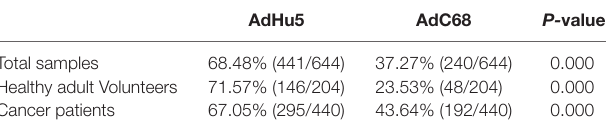
Table 2 | Seroprevalence of AdHu5 and AdC68 neutralizing antibody in cancer patients and healthy adult volunteers.